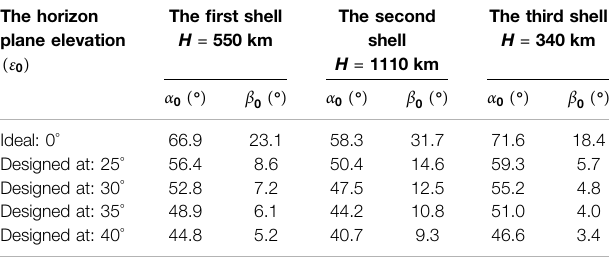
TABLE 4 | Nadir angle and central angle for different